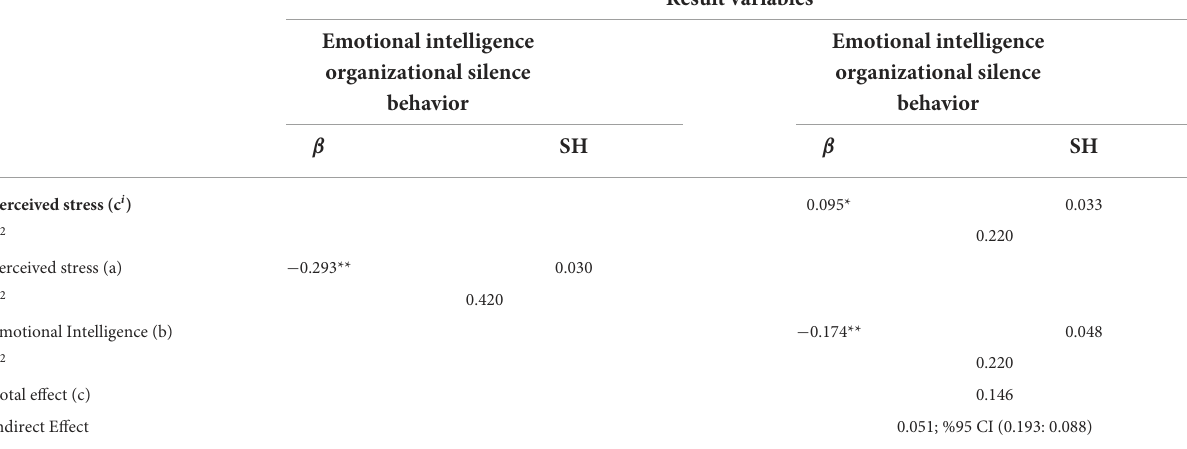
TABLE 3 The role of emotional intelligence in the effect of perceived stress on organizational silence behavior (H4).